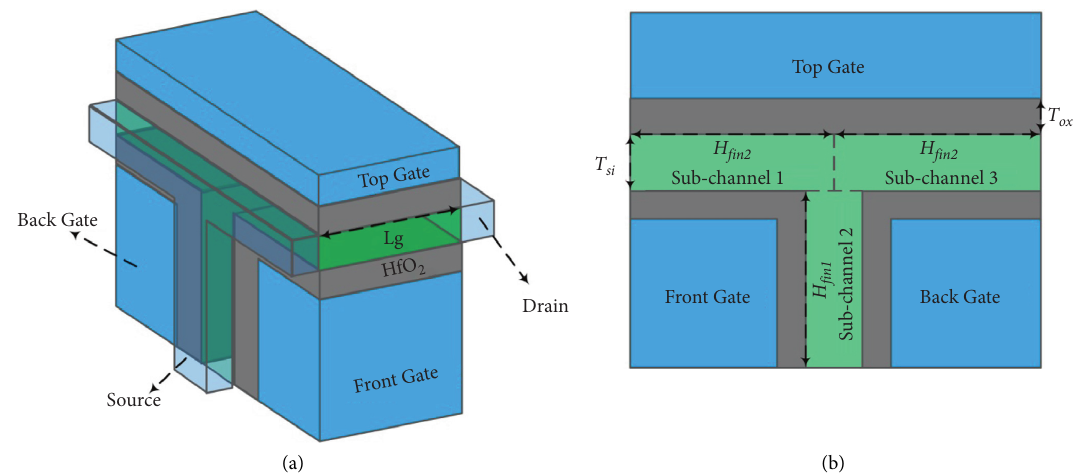
Figure 1: The structure of the PSF-TiFET device. (a) 3D view and (b) cross-sectional view. Table 1: The optimized parameters of PSF-TiFET. Parameter Value